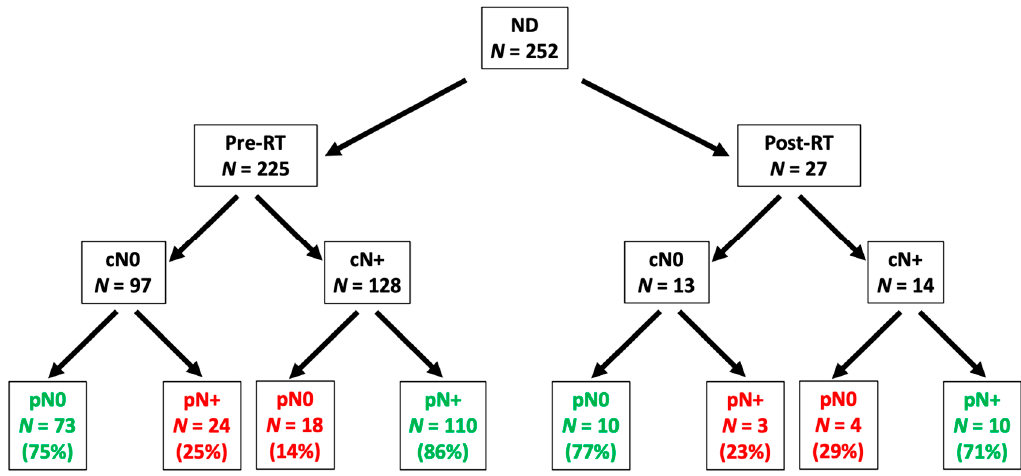
Figure 1. Workflow showing clinical and pathological status in 252 patients undergoing neck dissection. 3.2. Radiation Induces Reduction of Lymph Node Yield but Not Lymph Node Ratio We determined LNY and LNR in patients undergoing ND before and after CRT (Table 2). LNY and LNR were compared using all sides, then comparing SND vs. MRND, and finally per nodal level. LNY was significantly higher patients undergoing upfront ND than in those undergoing salvage ND (median: 38 vs. 22, p < 0.0001), with a higher level of significance in MRND. The differences between upfront and salvage ND were significant for all nodal levels, except for level V, which is the level with the lowest LNY. Table 2. Lymph node yield and lymph node ratio prior and after CRT. n = 335 specimens. Neck Dissection Features Total p Value